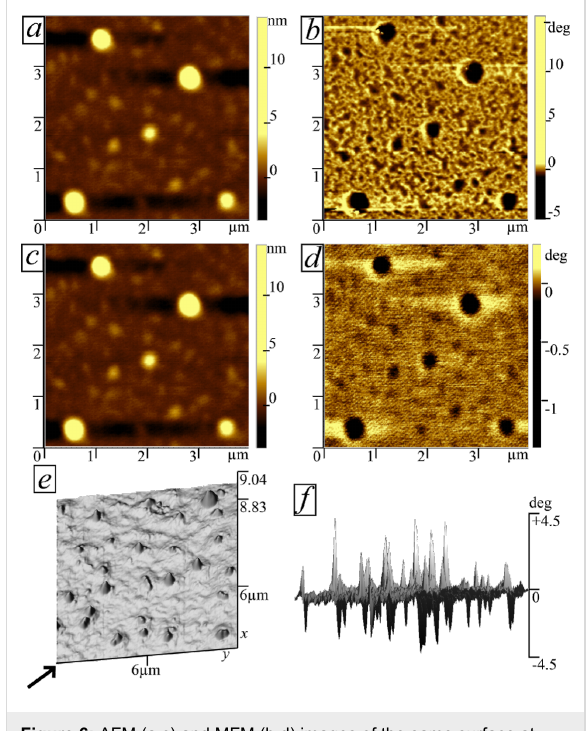
Figure 6: AFM (a,c) and MFM (b,d) images of the same surface at 303 K (a,b) and 413 K (c,d). AFM (e) and MFM (f) three-dimensional image of the surface containing ferromagnetic inclusions. The arrow in (e) corresponds to the direction for which MFM image (f) was